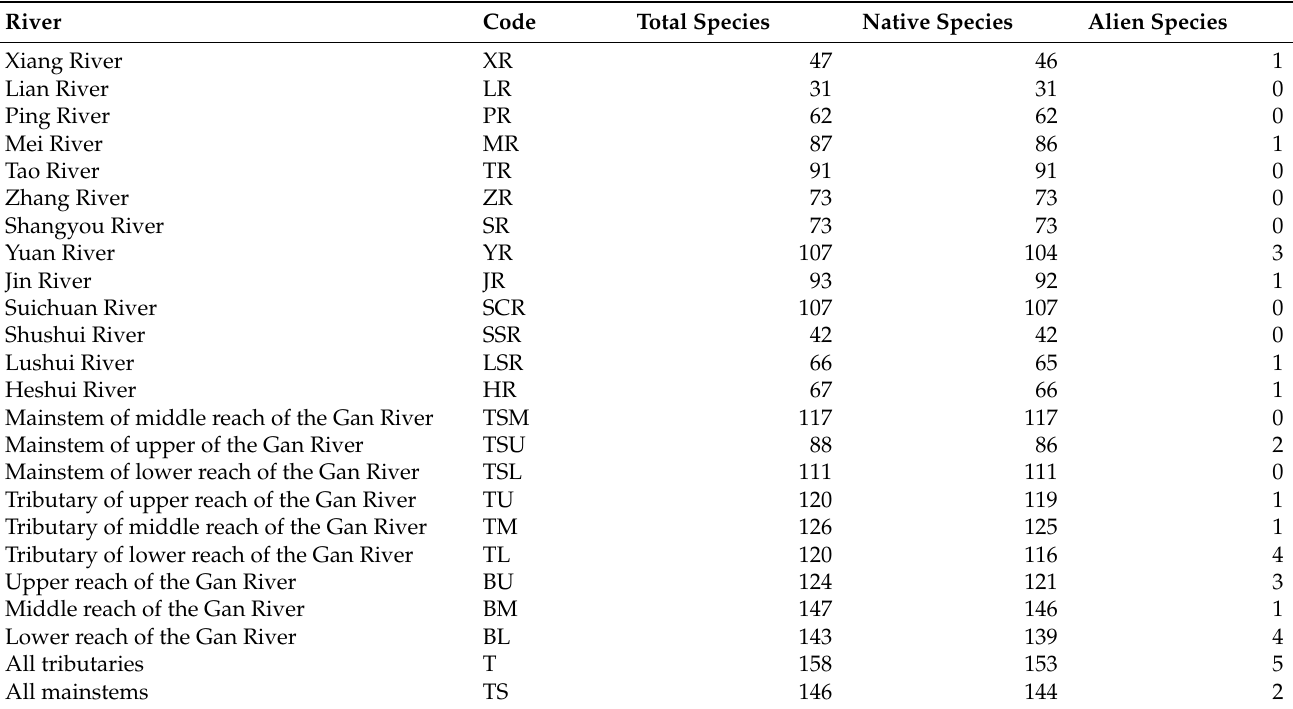
Figure 2. Alpha diversity (# of species) according to origin ( A ) and family ( B ) in the Gan River Basin for the historical (red) and current (black) time periods. Table 1. The alpha diversity and gamma diversity of total, native, and alien fish species in the current period from the Gan River Basin.